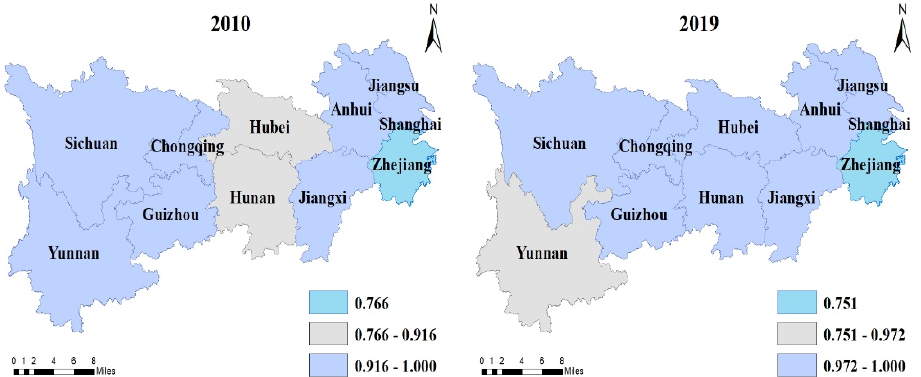
Figure 5. Same as Figure 3, but for scale efficiency.